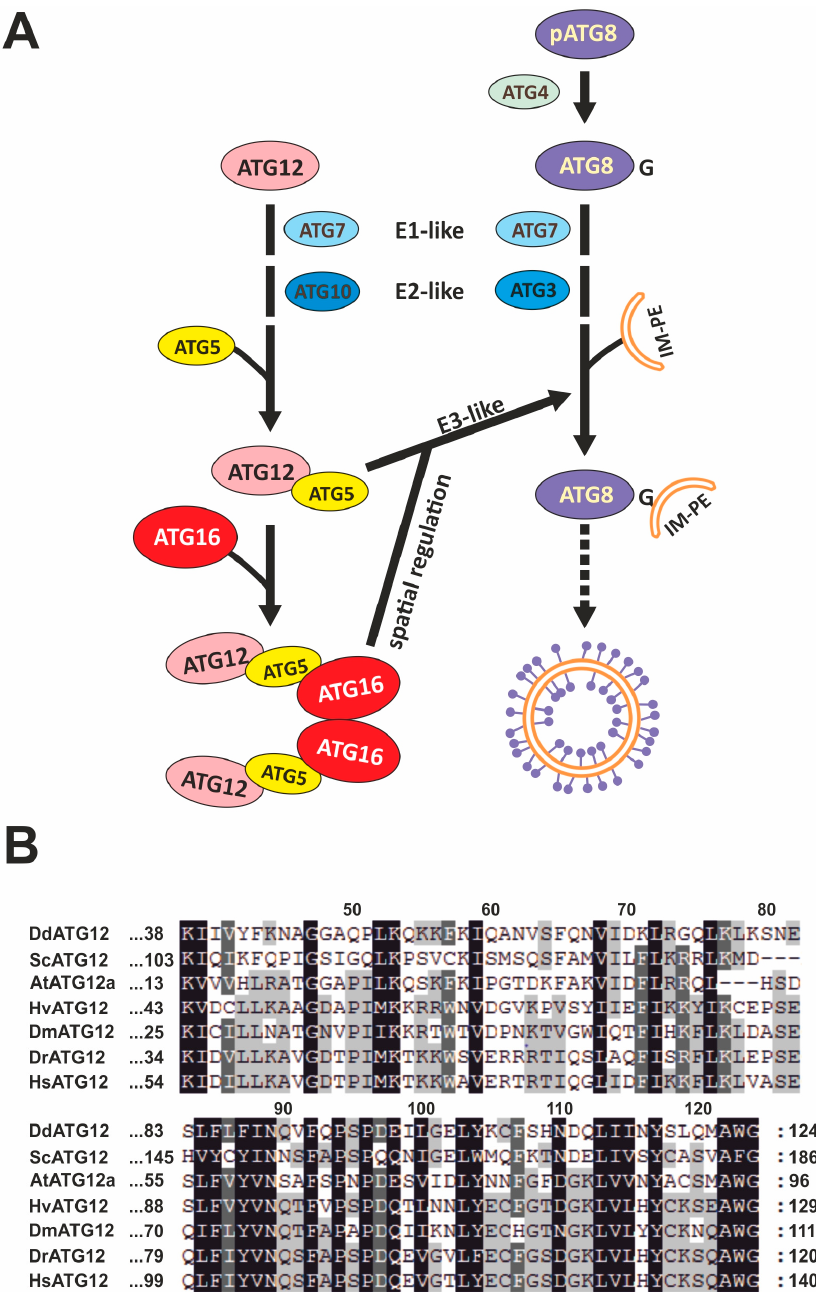
Figure 1. The two ubiquitin-like conjugation systems and multiple sequence alignment of the APG12 1 domain. ( A ) Schematic representation of the components and their interrelations of the two ubiquitin-like conjugation systems in autophagy. The ATG12 (left) and the ATG8/LC3 (right) conjugation systems are depicted. The different components of the two conjugation systems are not drawn to scale. Legend: pATG8, proATG8; IM-PE, isolation membrane containing phosphatidylethanolamine. Modified from Pyo et al. [30]. See text for further details. ( B ) Multiple sequence alignment of ATG12 orthologs. The highly conserved APG12 domain of ATG12 from different organisms is shown. The multiple sequence alignment was performed with Clustal Omega [31] and displayed using the Genedoc program (v. 2.7). Amino acid residues are numbered and sequence similarity is indicated by shading. Conserved percent: dark grey = 100%, medium grey = 80%, light grey = 60%. Legend: Dd, Dictyostelium discoideum ; Sc, Saccharomyces cerevisiae ; At, Arabidopsis thaliana ; Hv, Hydra vulgaris ; Dm, Drosophila melanogaster ; Dr, Danio rerio ; Hs, Homo sapiens